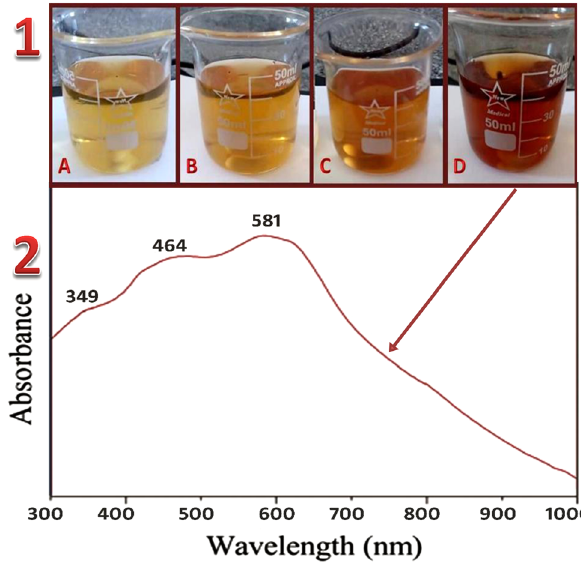
Figure 1: Color indicators of Se - NRs synthesis by pomegranate rind extract showing: ( 1 ) visual appearance after incubation for 0 ( A ) , 20 ( B ) , 40 ( C ) , and 60 min ( D ) ; and ( 2 ) UV - Vis spectrum of biosynthesized Se -